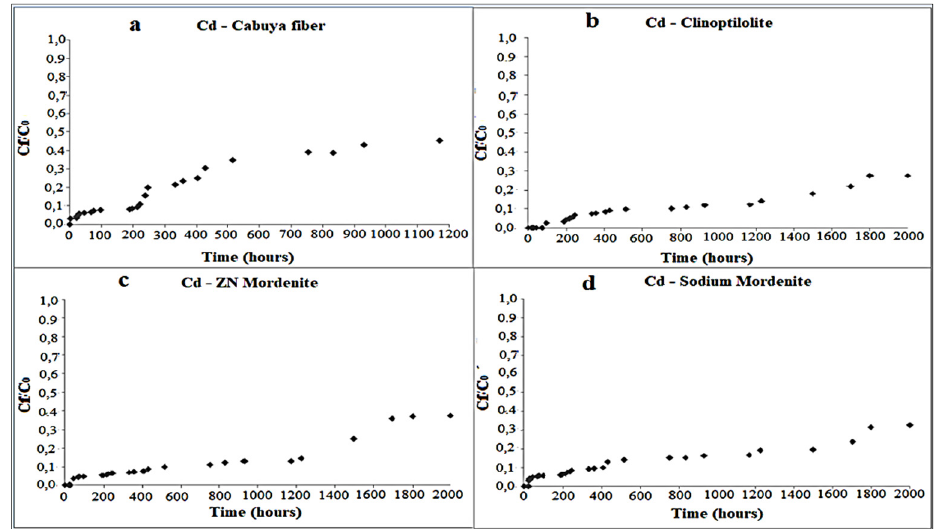
Figure 5. Variation of Cd concentration over time, in the column tests, for the following reactive materials: ( a ) cabuya fiber; ( b ) clinoptilolite zeolite; ( c ) mordenite zeolite; ( d ) sodium mordenite zeolite. The experimental conditions in ranges were: dynamic fluid, temperature: 26–28 °C and pH: 7.4–8.8.